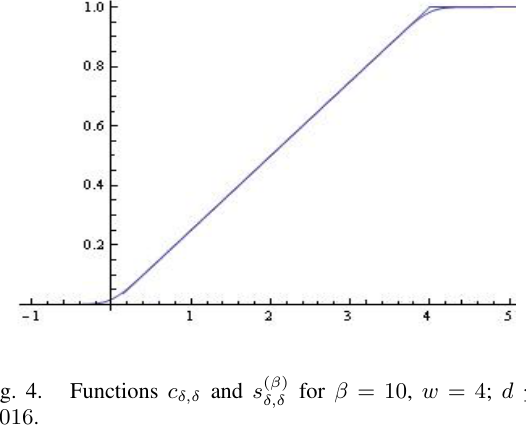
for β = 5 , w = 3 ; d ≤ 0 . 4 . δ,δ